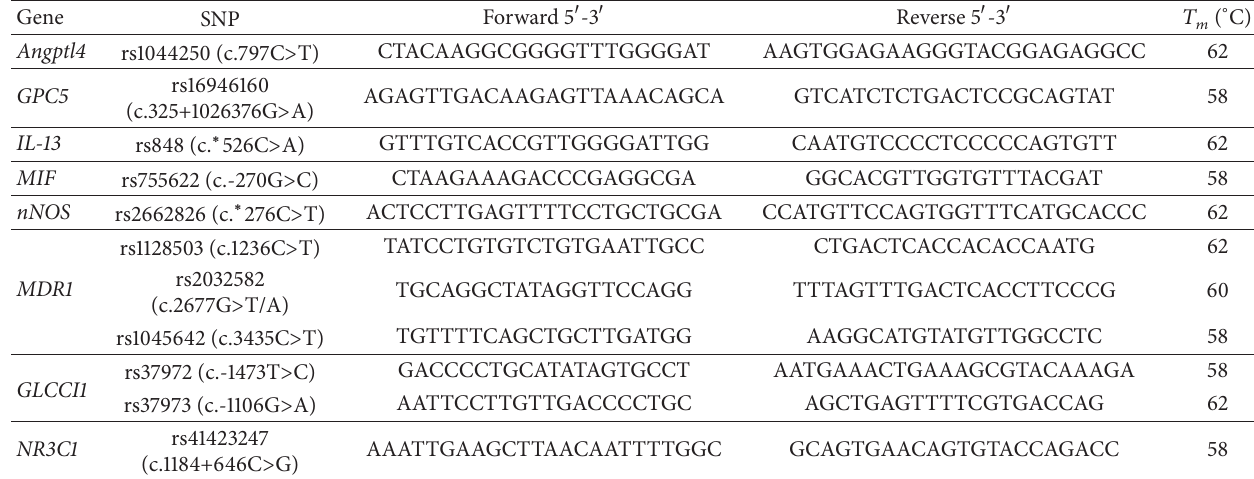
Table 1: Primer sequences. 𝑇 𝑚 , annealing